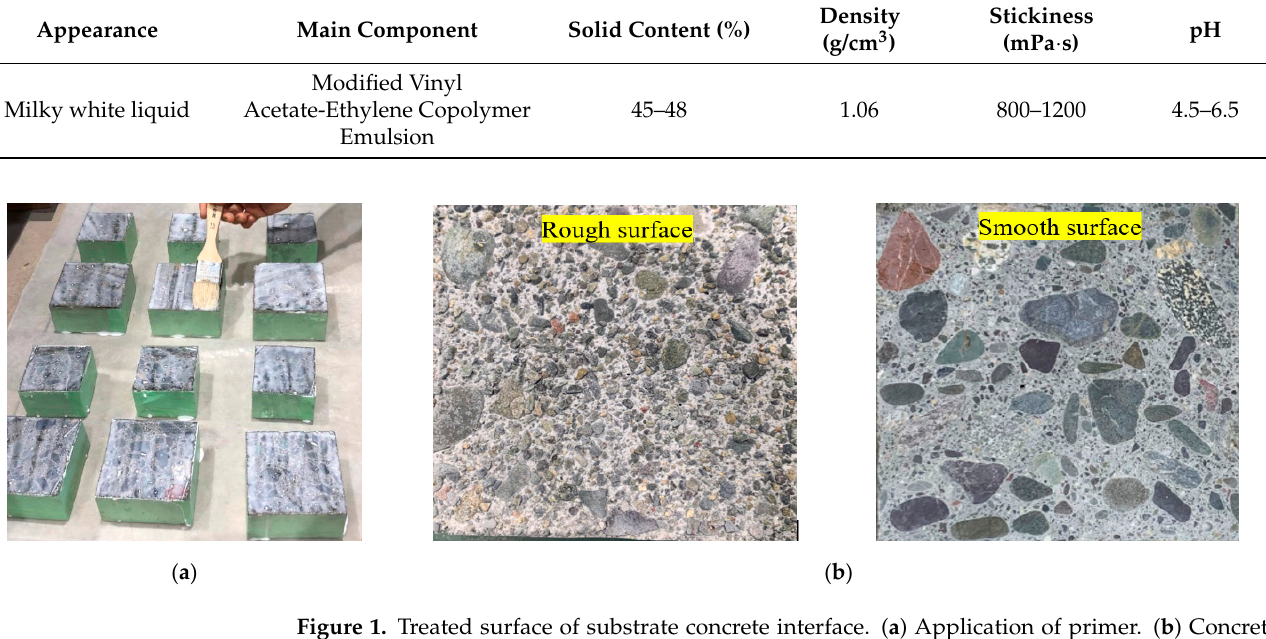
Table 3. Technical characteristics of primer.